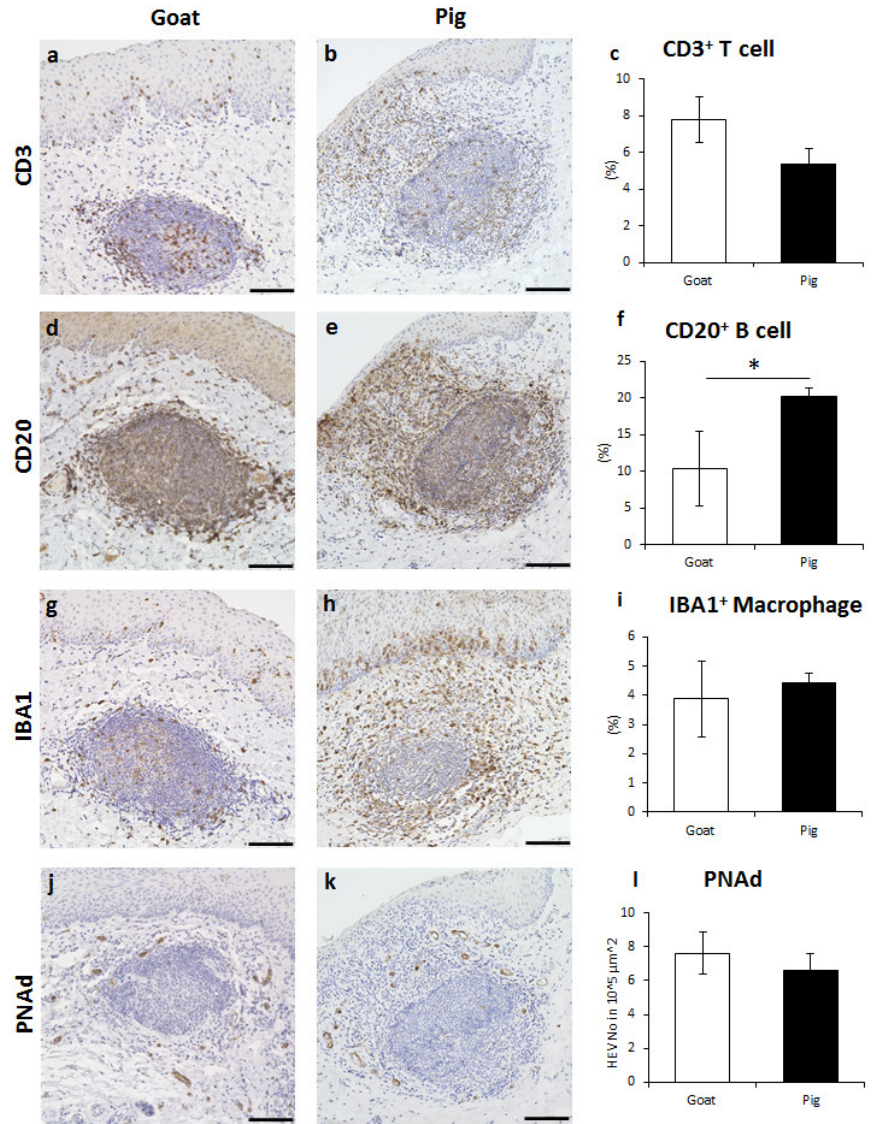
Figure 3. Immune cell characteristics composing LN in goat and pig VV. ( a , b ) CD3 for T cells of goat and pig. ( c ) Positive percentage of CD3 + T cells localizing in the LN. Values = mean ± SE. n ≥ 4. ( d , e ) CD20 for B cells of goat and pig. ( f ) Positive percentage of CD20 + B cells localizing in the LN. Values = mean ± SE. n ≥ 4. Significant difference between the goats and pigs is indicated by *, p < 0.05; Mann–Whitney U test. ( g , h ) IBA1 for macrophages of goat and pig. ( i ) Positive percentage of IBA1 + macrophages occupying the LN. Values = mean ± SE. n ≥ 4. ( j , k ) PNAd for HEVs of goat and pig. ( l ) Number of PNAd + HEVs in 10 5 μm 2 in LN. Values = mean ± SE. n ≥ 4 . Scale bars = 100 μm.